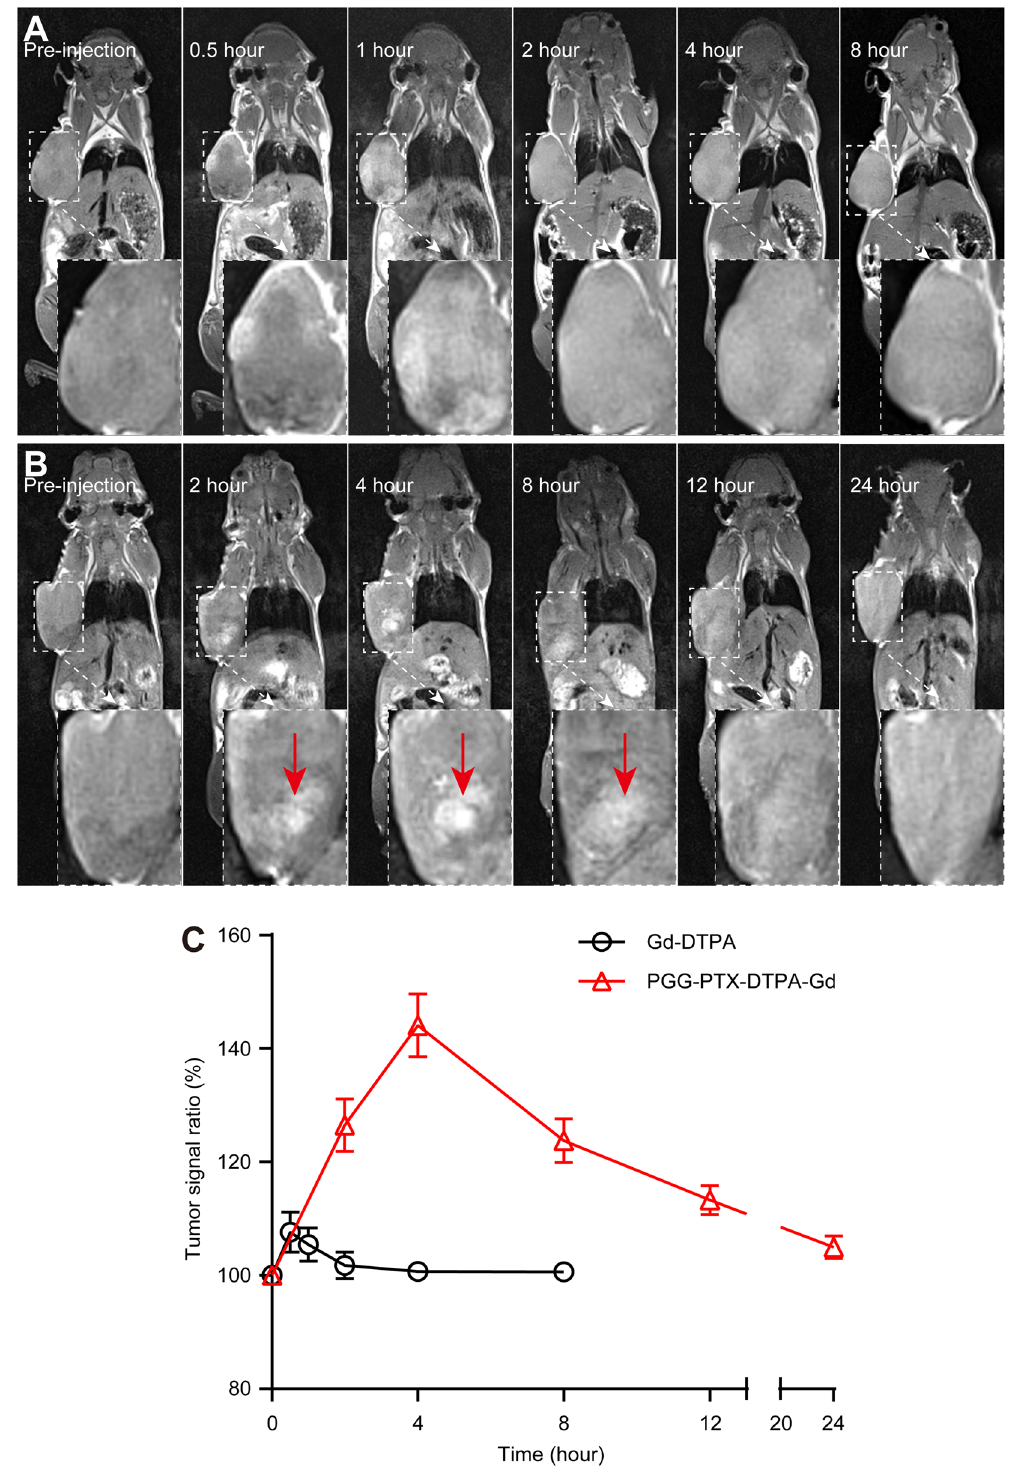
Figure 5. MR imaging of NCI-H460-bearing nude mice (n = 3) with PGG-PTX-DTPA-Gd NPs in vivo . Representative in vivo T 1 -weighted MR images of NCI-H460-bearing nude mice following i.v. administration of free Gd-DTPA ( A ) at different time points (pre-injection, 0.5, 1, 2, 4, 8 hour) and PGG-PTX-DTPA-Gd NPs ( B ) at different time points (pre-injection, 2, 4, 8, 12, 24 hour). ( C ) Quantitative analysis of T 1 -weighted MR images tumor contrast enhancement after i.v. injection of free Gd-DTPA and PGG-PTX-DTPA-Gd NPs. The average MR relative signal enhancement was measured for each tumor. The higher contrast of tumor positions by PGG- PTX-DTPA-Gd NPs are resulted from the promoted tumor accumulation and the increased relaxivity of PGG- PTX-DTPA-Gd